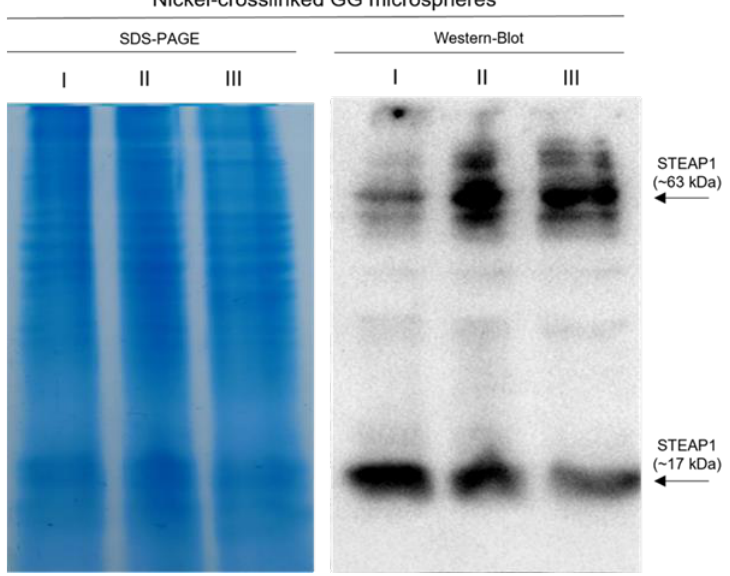
Figure 6. SDS-PAGE and Western blot of the recovered supernatants from affinity batch with nickel-crosslinked GG microspheres; I—sample that did not bind to GG microspheres at 10 mM Tris pH 9.2 with 150 mM NaCl and 5 mM imidazole; II—washing step with 10 mM Tris pH 9.2 with 150 mM NaCl and 50 mM imidazole; III—elution step with 10 mM Tris pH 9.2 with 150 mM NaCl and 500 mM imidazole.